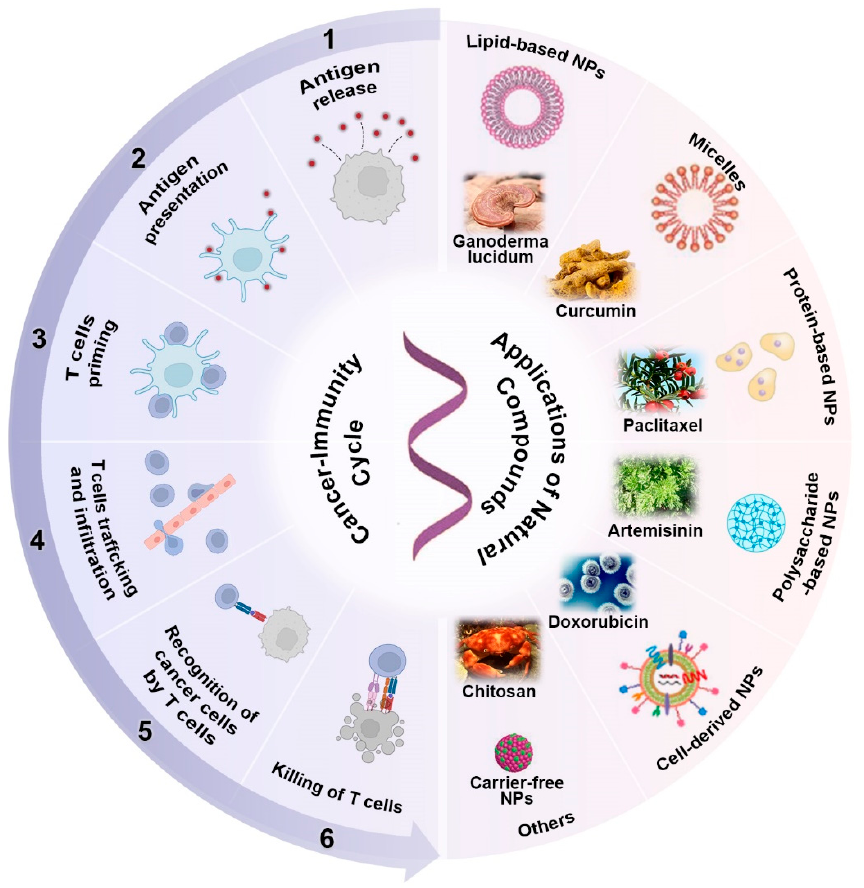
Figure 1. An overview of different steps of the immune response, delivery strategies, and biomedical applications of natural compounds for cancer immunotherapy.